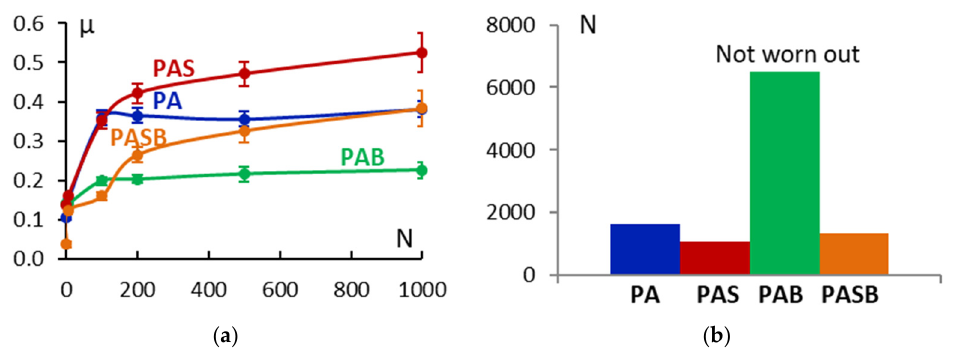
Figure 11. Change in the coefficient of friction depending on the number of revolutions ( a ) and the number of revolutions before destruction of the coating ( b ) for the PEO-coated samples PA, PAS, PAB, and PASB.